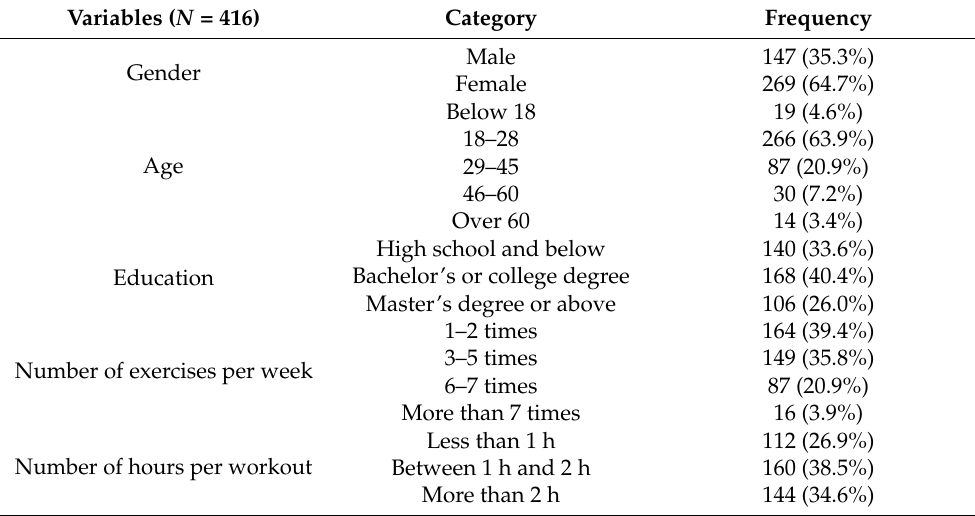
Table 1. Demographic profile of the survey participants ( N =